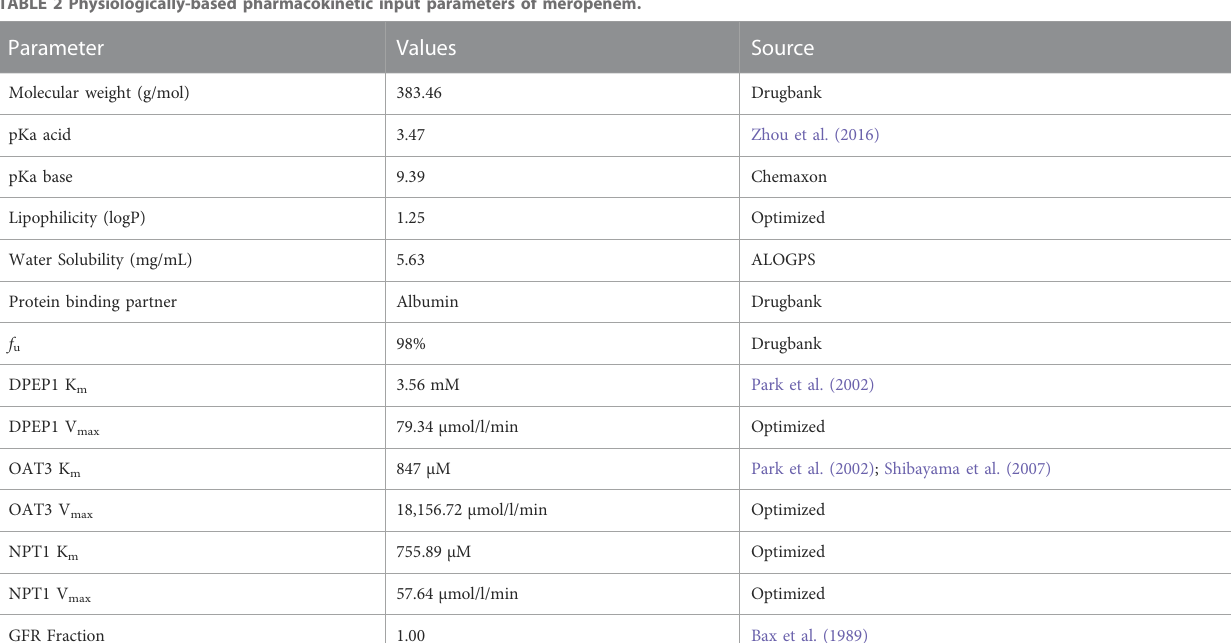
Figure 5. In comparison to the conventional dose infusion (30min),